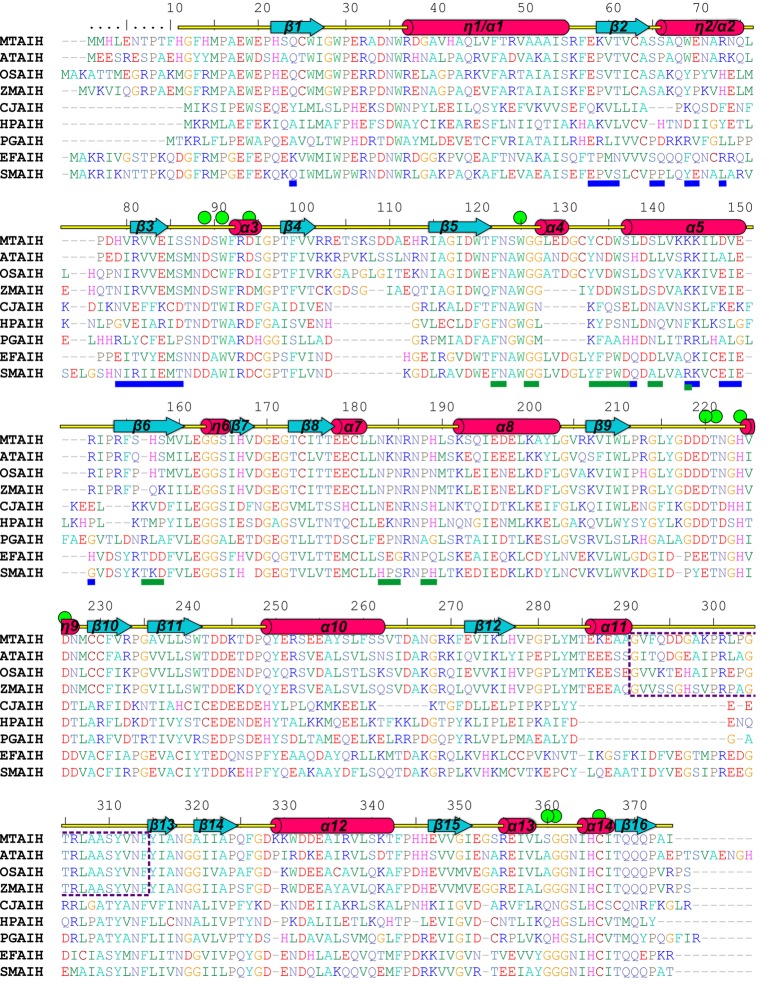
Sequence alignment of selected AIHs. The alignment was made with the following AIH sequences (UniProt accession numbers are given in square brackets, as well as the sequence identity with MtAIH): MtAIH [G7JT50], AtAIH [Q8GWW7, 70% sequence identity], OsAIH [Q01KF3, 65%], ZmAIH [C0PHP8, 64%], CjAIH [Q0P9V0, 26%], HpAIH [O24890, 26%], PgAIH [Q7MXM8, 27%], EfAIH [Q837U5, 44%], SmAIH [Q8DW17, 45%]. Sequence positions above the alignment and annotation of the secondary structure elements (α helices and 310 helices, η, are shown as red cylinders and β strands are shown as cyan arrows) correspond to MtAIH. Residues are color-coded by type. Green circles indicate residues that form the active site or participate in the interactions with the bound substrate. Blue and green lines below the alignment indicate residues that form dimer interface in MtAIH and HpAIH, respectively. The gate-keeping loop over the active site of plant AIHs is marked with a purple dotted line.